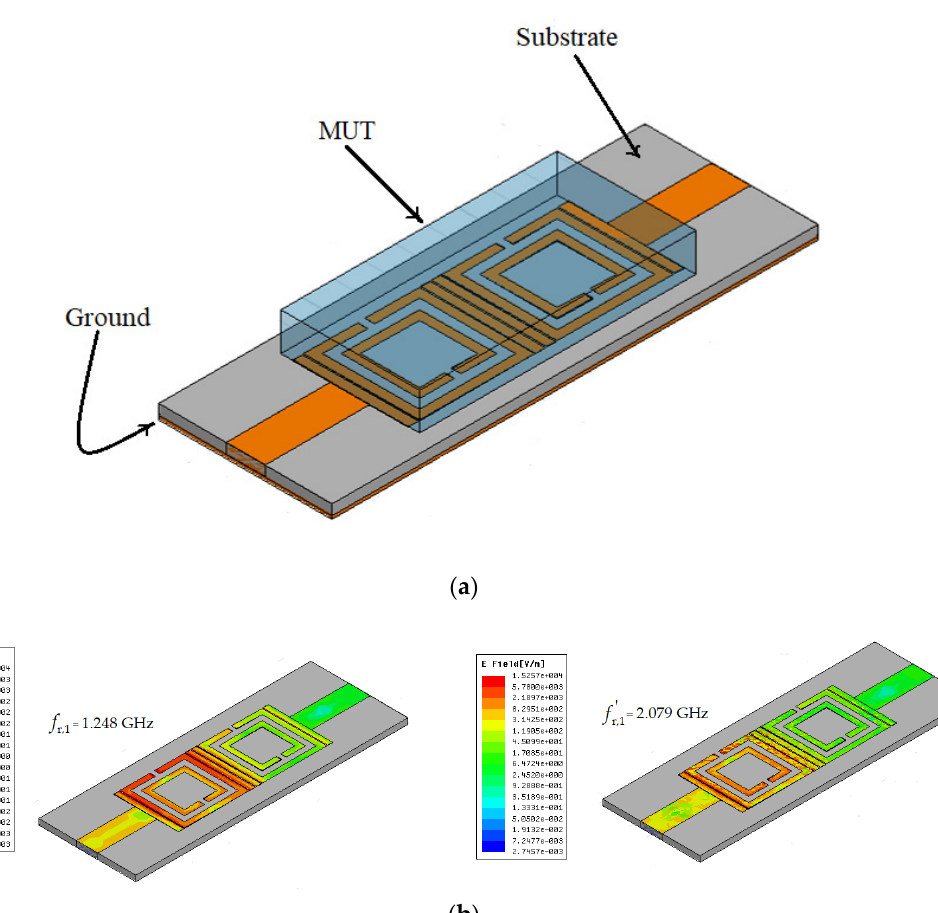
Figure 4. The vertical strips (VS)-SRR sensor: ( a ) Setup of the VS-SRR sensor with material under test (MUT) placed over the two modified SRR unit cells, ( b ) 3D representation of the intensity of the electric field at the first resonant frequency and at the second resonant frequency.